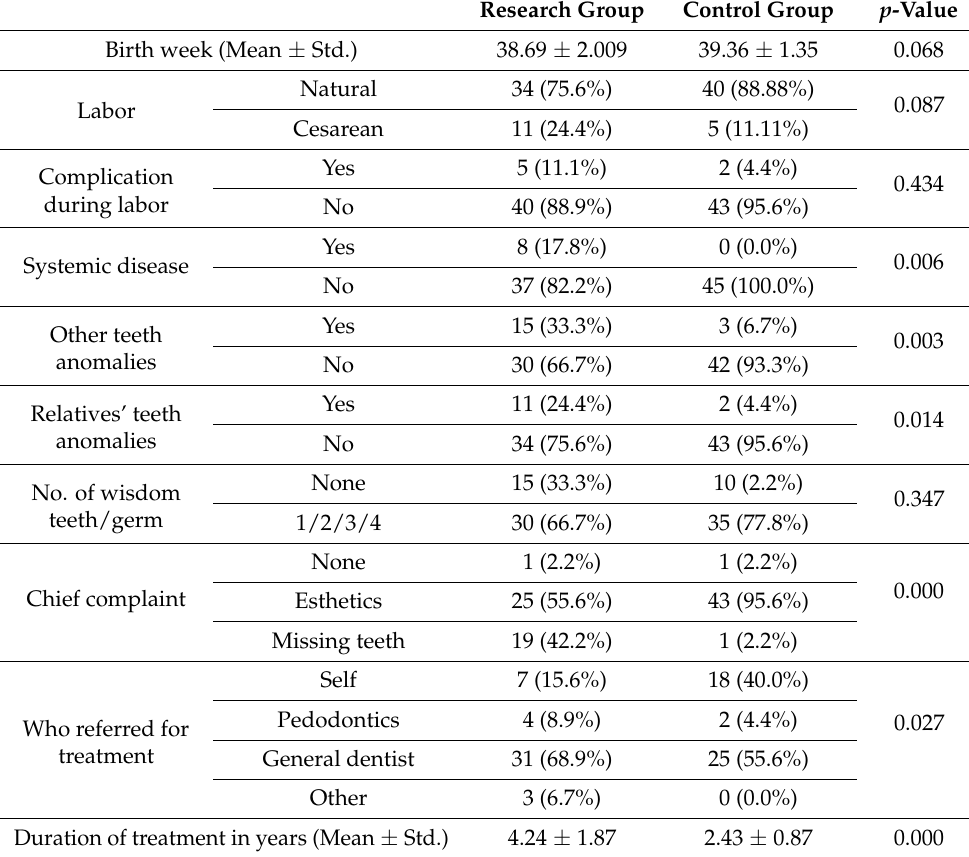
Table 2. Comparative variables between the research group and the control